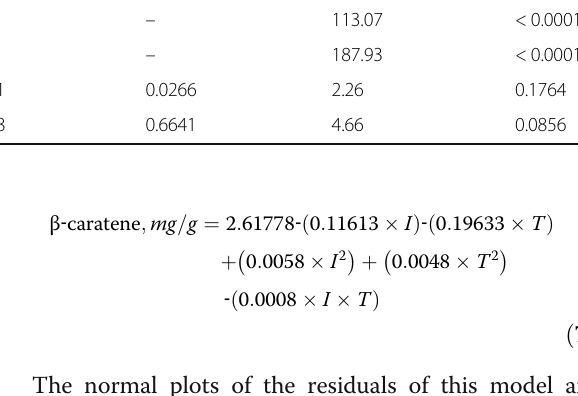
shown in Fig. 3. and the surface plot and contour of lu- tein is shown in Fig. 4. The analysis of the quadratic model of β -carotene re- sponse yielded two linear coefficients (A, B), two quad- ratic coefficients (A 2 , B 2 ), and one cross-product coefficient for the full model. The statistical analysis of β -carotene content response revealed that both the R 2